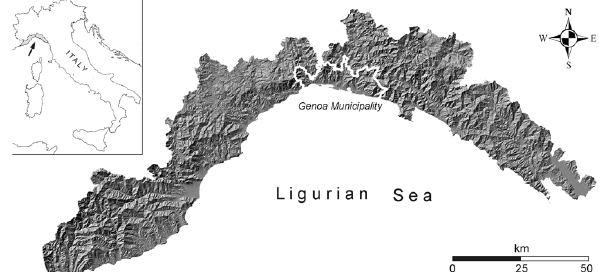
Fig. 1. Location of the study area (relief image derived from 25m DTMs – Regione Liguria – using